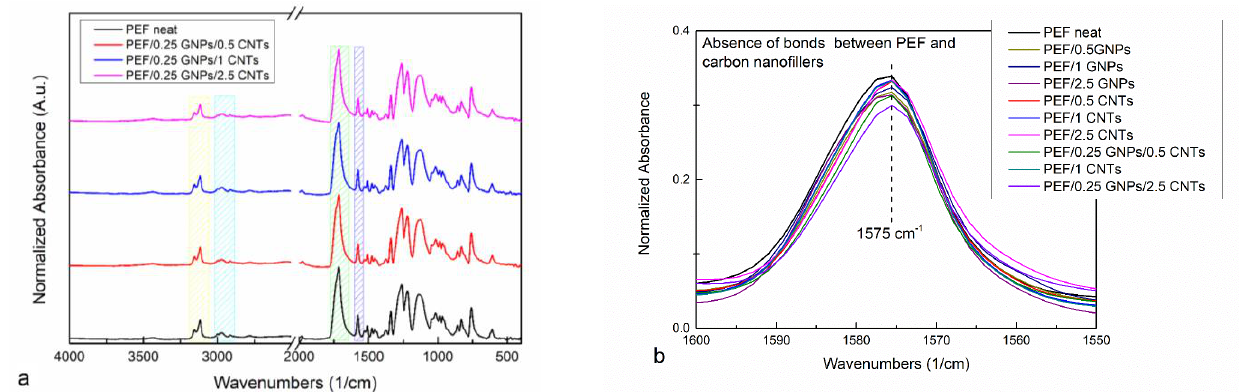
Figure 3. ATR spectra of neat PEF with ( a ) PEF/0.25 GNPs/CNTs and ( b ) enlarged ATR spectra of the ester bond band of all the PEF materials.